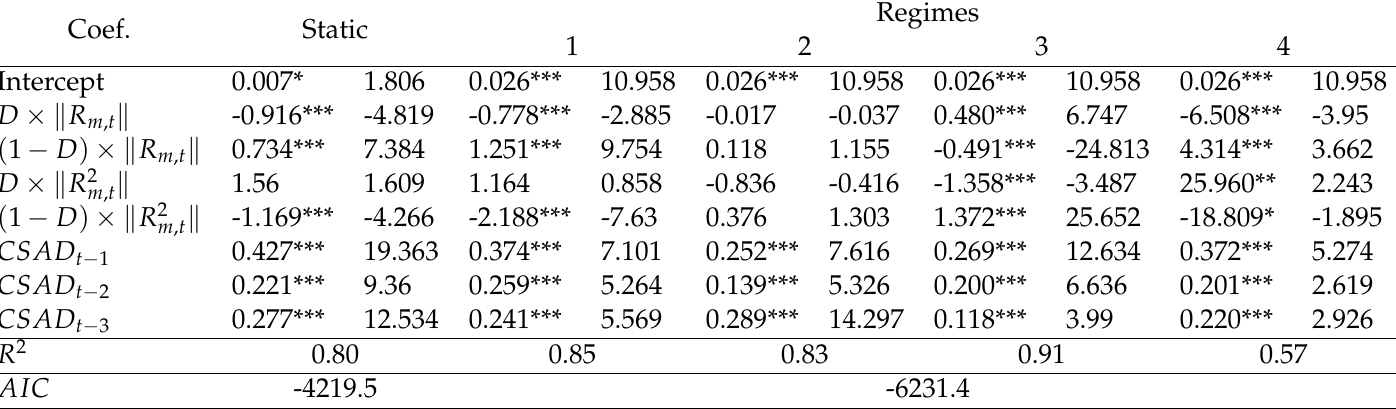
Table 3: Regression estimates of herding behavior on the full sample under asymmetric states Regimes Coef. Static 1 2 3